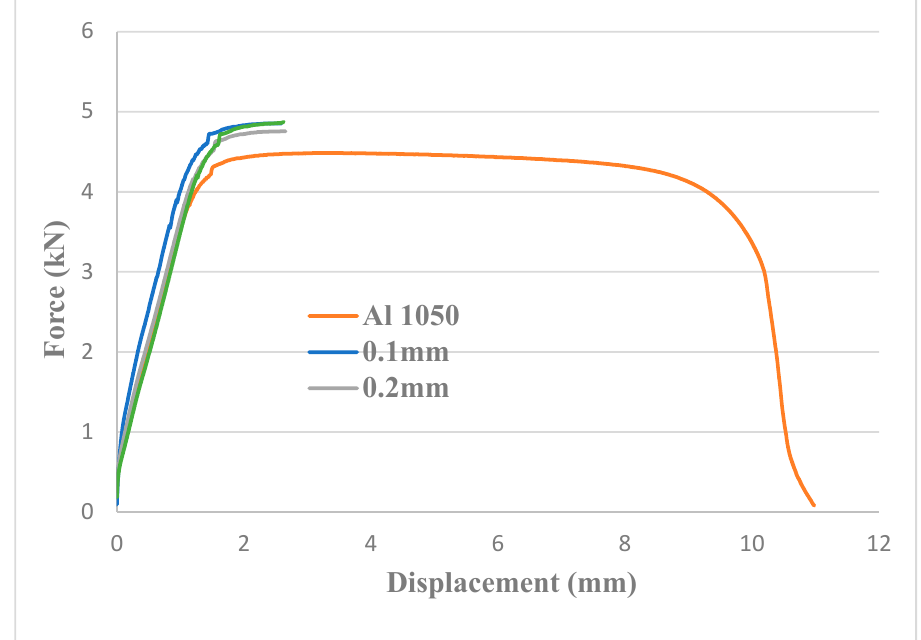
Figure 15. Fractured CMFM specimen tensile tested after being immersed in distilled water and NaCl solution. J. Compos. Sci. 2018 , 2 , x